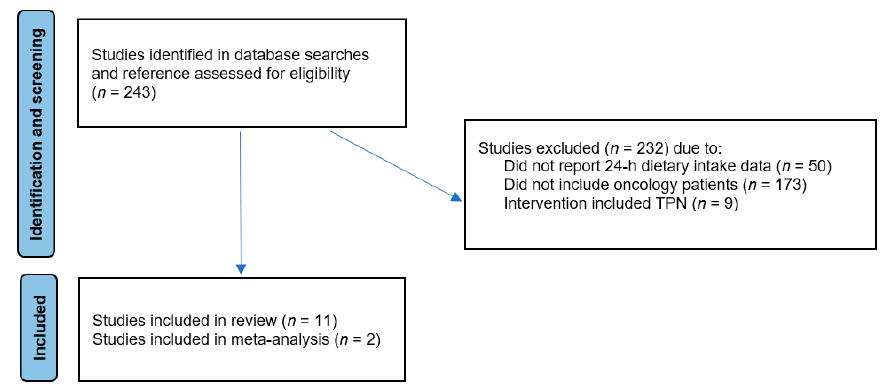
Figure 1. Flow diagram of study selection.